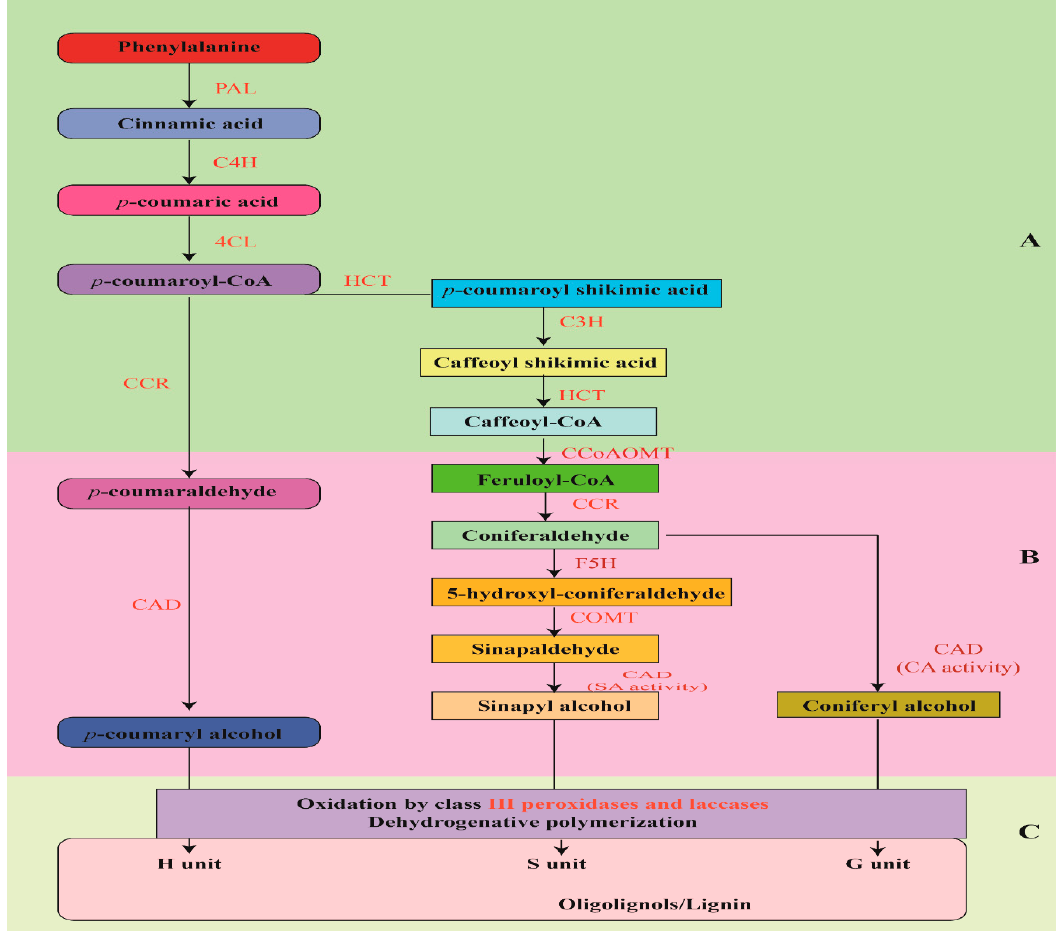
Figure 3. General steps involved in lignin biosynthesis pathway in plants. ( A ): Phenylpropanoid pathway showing the synthesis process of monolignols from phenylalanine, ( B ): monolignol-specific pathway, ( C ): Sub units namely: (guaiacyl), S (syringyl), and H (hydroxyphenyl oxidized from above steps form three-dimensional polymer of